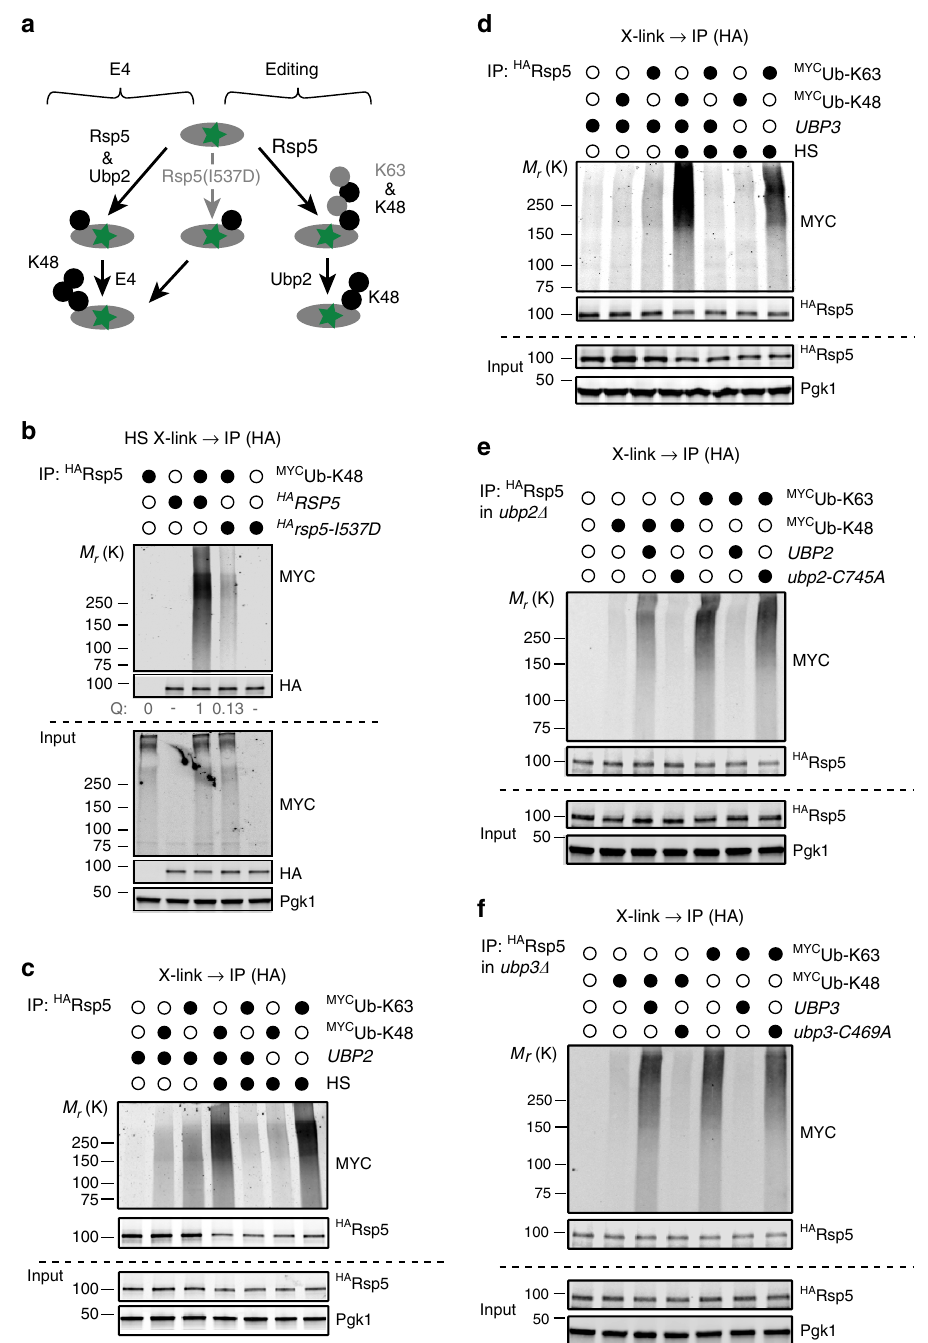
Figure 5 | Rsp5 conjugates K48-linked ubiquitin chains to its heat-induced substrates in vivo in an Ubp2 and 3-dependent manner. ( a ) Schematic representation of two possible models to explain the role of Rsp5 in the assembly of K48 chains after HS. The I537D mutant of Rsp5 that impairs mostly poly- but not monoubiquitination should only strongly affect the editing pathway. ( b ) Cells that expressed 3HA Rsp5 or 3HA Rsp5-I537D together with empty or MYC ubiquitin-K48 only constructs were heat shocked for 20min (40 (cid:2) C) and crosslinked with 1% formaldehyde for the remaining 10min before lysis with SDS and the anti-HA IP. Western blot analysis of both IP and input samples are shown. ( c , d ) WT and ubp2 D ( c ) or ubp3 D ( d ) cells that expressed 3HA Rsp5 together with empty, MYC ubiquitin-K48 only or MYC ubiquitin-K63 only constructs were heat shocked (40 (cid:2) C, 20min) or not, and crosslinked with 1% formaldehyde before lysis with SDS and IP with anti-HA antibody-conjugated magnetic beads. Western blot analysis of both IP and Input samples are shown. ( e , f ) As in b , c , the ubp2 D ( e ) or ubp3 D ( f ) cells carried out either an empty control plasmid or a plasmid that expressed the WT or catalytically inactive